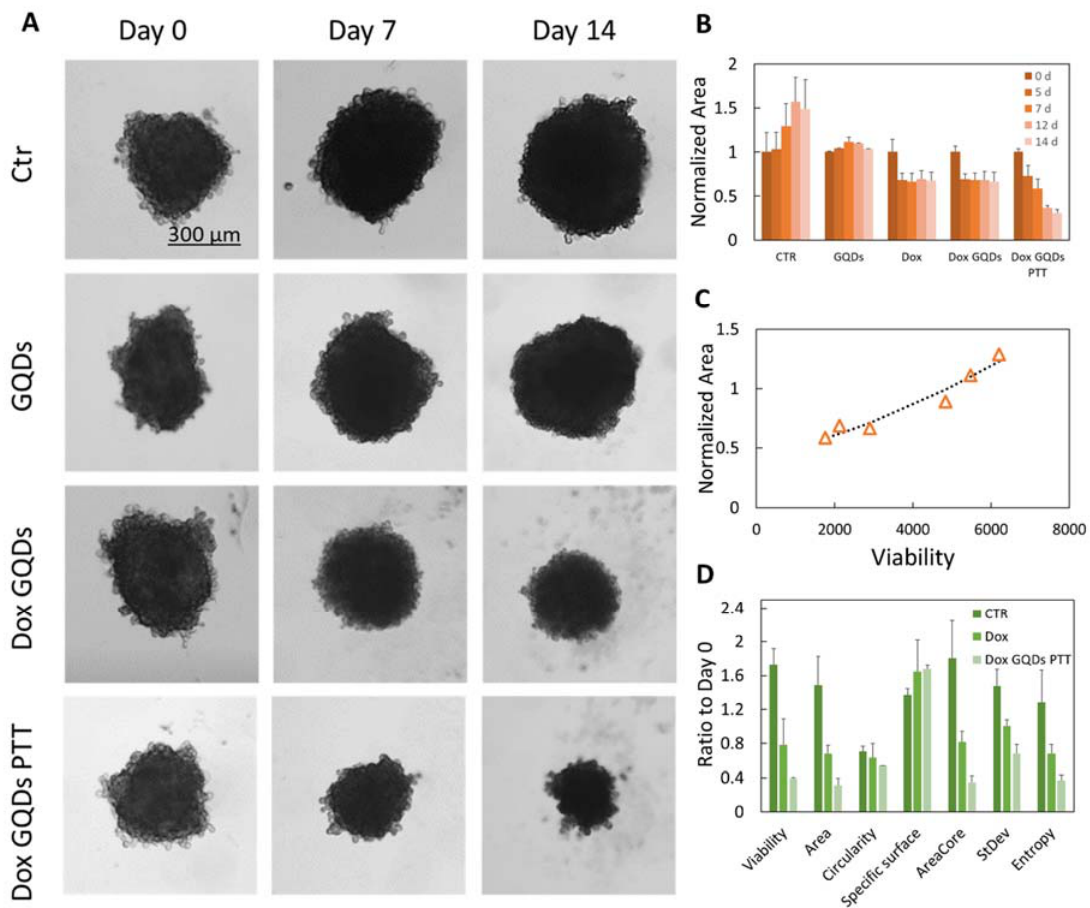
Figure 4. ( A ) Representative images at days 0, 7 and 14 of U87 control (Ctr) spheroids and treated with GQDs, Dox GQDs, or Dox GQDs PTT. ( B ) Effect of treatments on spheroids area, obtained from binarized images and normalized to Day 0. ( C ) Correlation between normalized area and via ‐ bility after 7 days of treatment and non ‐ linear fit of data with equation ax 3/2 + b and parameters a = 1.57 × 10 − 6 ± 1.8 × 10 − 7 , b = 0.47 ± 0.06. ( D ) Comparison of different parameters obtained with INSIDIA 2.0 after 14 days of treatment.